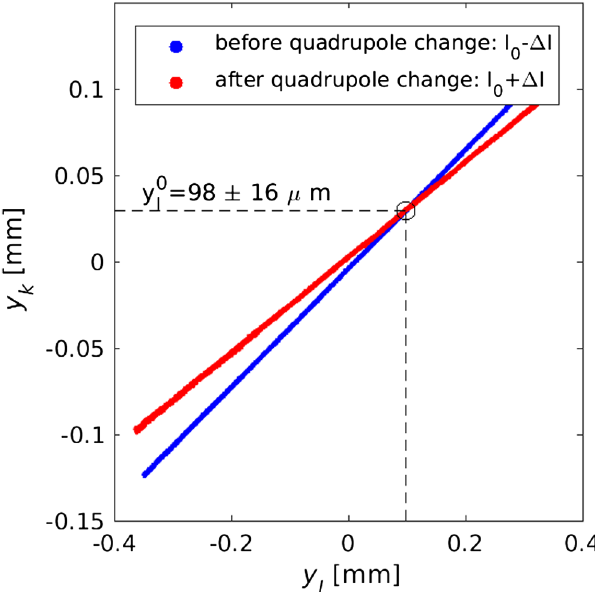
FIG. 2. Example of measured only vertical plane FBBA. The BPM offsets leading to the on-axis crossing of the beam through the quadrupole are inferred from the intercept of the two lines: before (blue) and after (red) the quadrupole change Δ I ¼ 2 . 5 A. The OCM was excited at 6 Hz. The data shown here corresponds to the case l ¼ 69